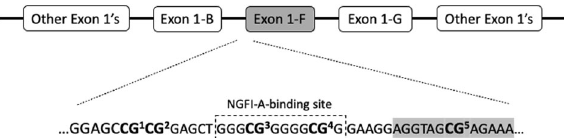
Fig. 1 The structure of NR3C1 exon 1 variants. The fi gure